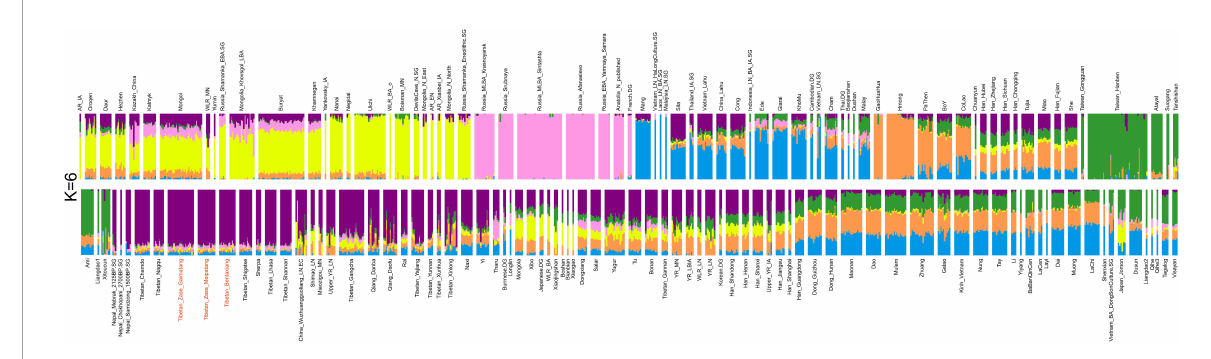
FIGURE2 Unsupervised model-based ADMIXTURE analysis for six predefined ancestral sources ( K = 6) based on the LD-pruned dataset (50,194 SNPs). We observed that our studied Nagqu Tibetans clustered with the published core Tibetans (Purple in the plot).